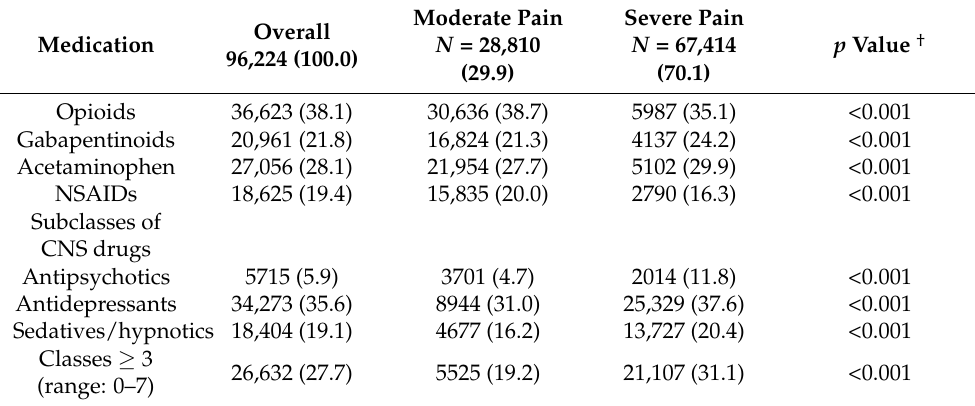
Table 2. Prevalence of pain medications among older US veterans with chronic pain prior to hospital- ization during fiscal year 2013, N